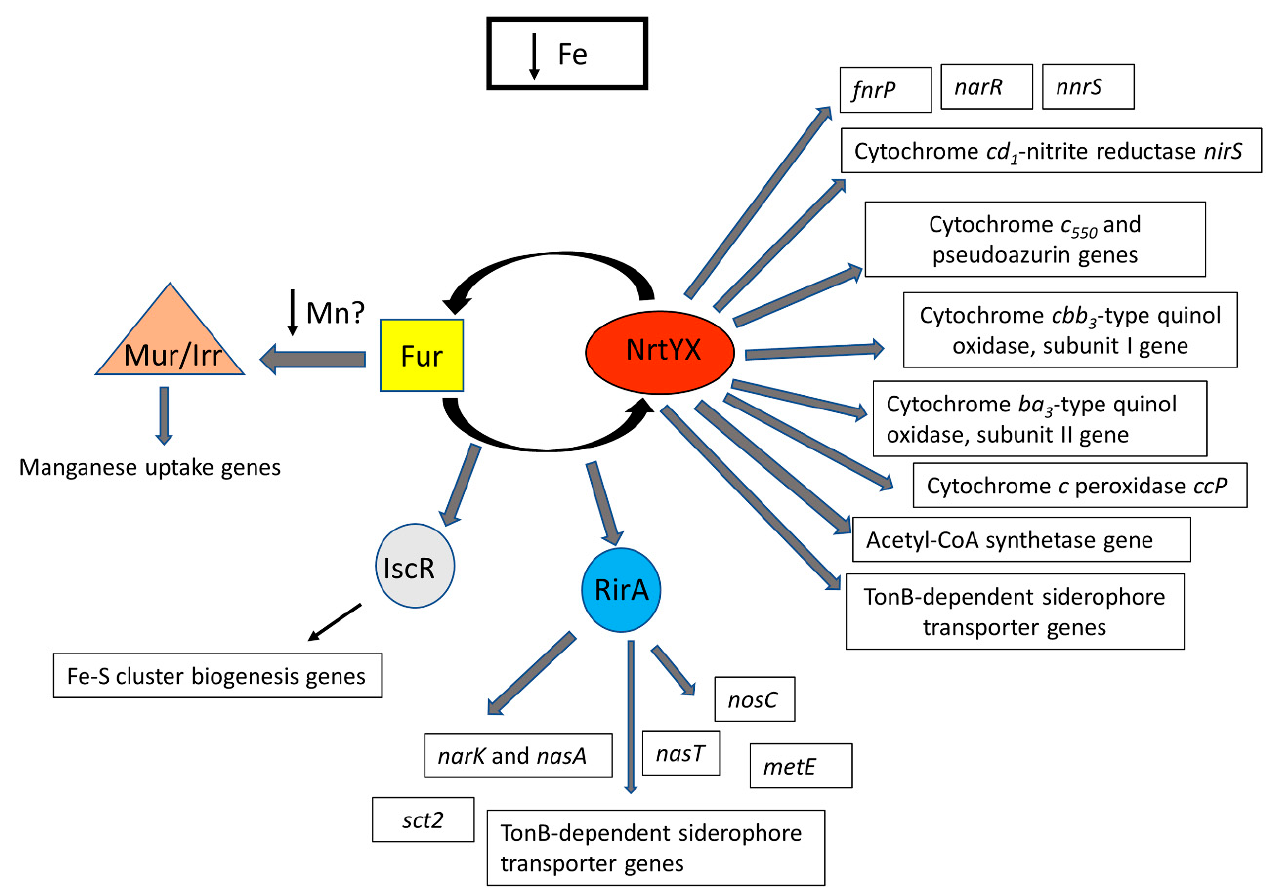
Figure 6. Hypothetical regulation network of the iron regulons in P. denitrificans . In this model, two major iron-responsive regulons have been included, NtrYX and Fur, which could display a cross-talk interaction. Other secondary transcriptional regulators that respond to iron limitation have also been regarded.